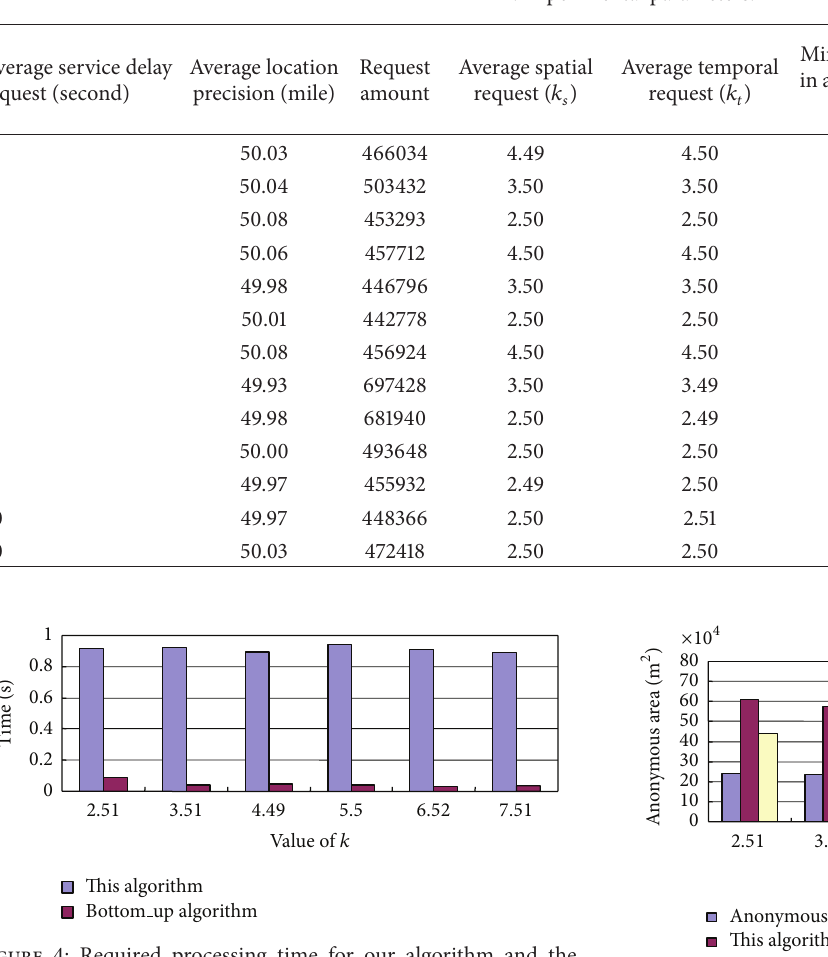
Table 1: Experimental parameters.